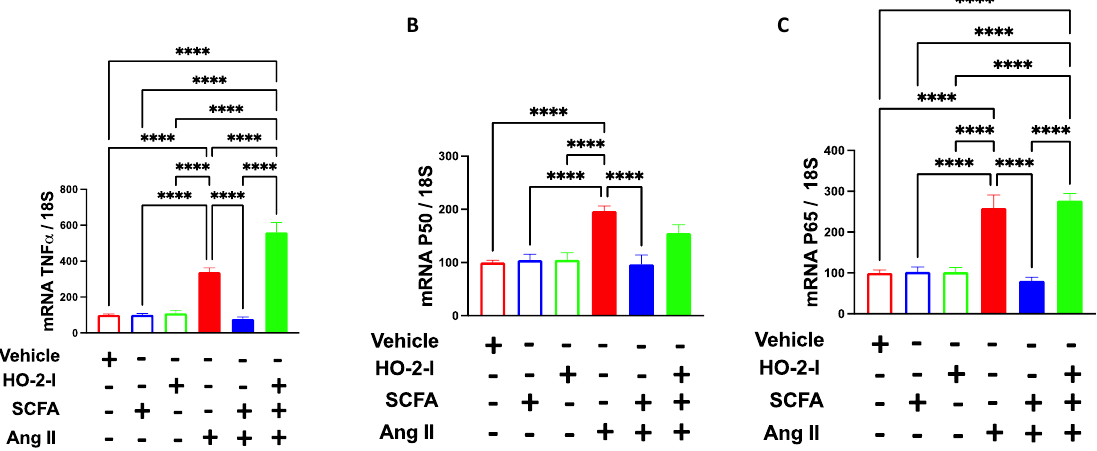
Figure 3. SCFAs reduce Ang-II-induced inflammation by mediating HO-2. qPCR for TNF α ( A ), p50 ( B ), and p65 ( C ) showing that the Ang-II-induced increases in these inflammatory markers in brain microvascular endothelial cells were reversed by the SCFAs/HO-2 axis. **** p < 0.0001. N = 7–8. SCFAs: short-chain fatty acids; Ang II: angiotensin II; HO-2 I: heme oxygenase 2 inhibitor; TNF α : tumor necrosis factor-alpha; and p50 and p65: NF- κ B subunits.